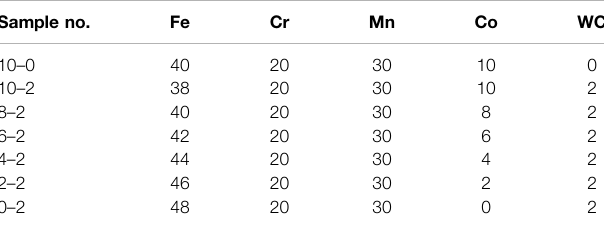
TABLE 1 | Chemical compositions of seven alloys after mechanical mixing (at.%). Sample